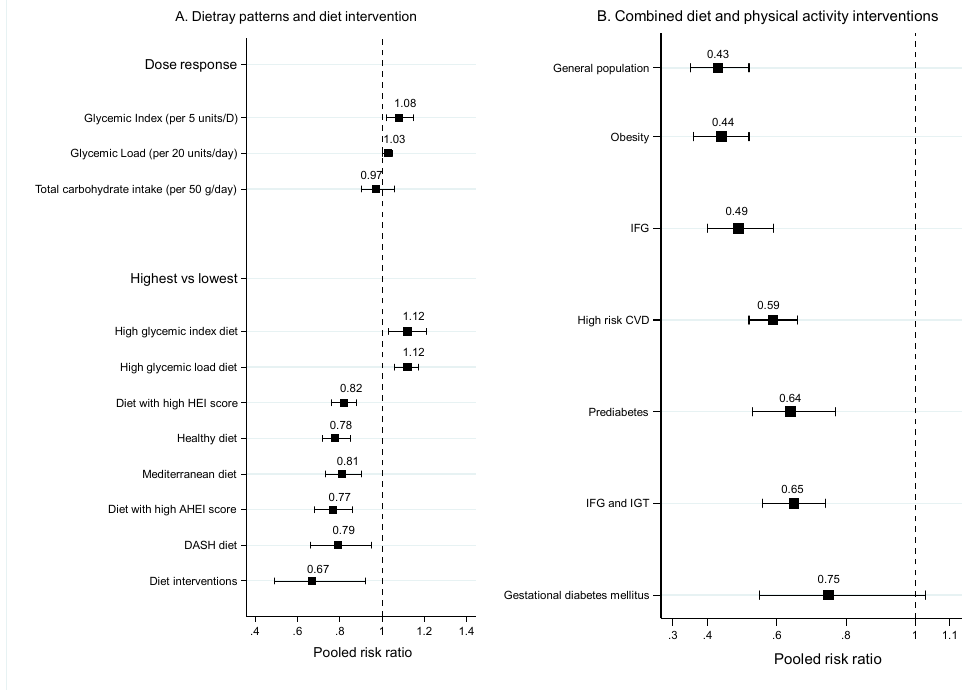
Figure 4. Pooled risk ratios of dietary patterns, diet and combined diet and physical activity interventions and risk of T2DM. ( A ) Dietary patterns and diet intervention. ( B ) Combined diet and physical activity interventions.